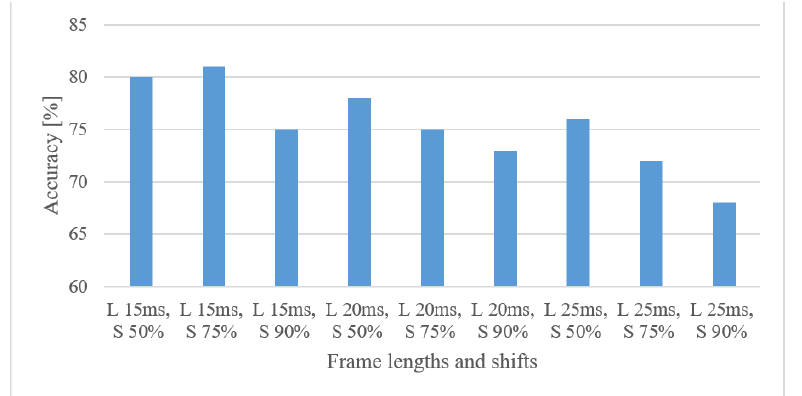
Figure 7. Accuracies for 15, 20, 25 ms frame lengths (L) and 50, 75, 90% shifts (S) between adjacent frames in the case of log spectrograms.